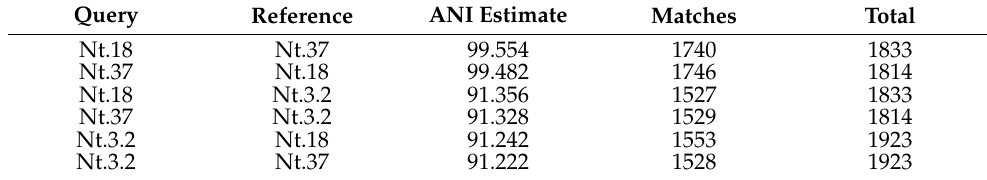
Table A3. Estimates of ANI values between B. toyonensis and B. wiedmannii isolate genomes using FastANI. Query